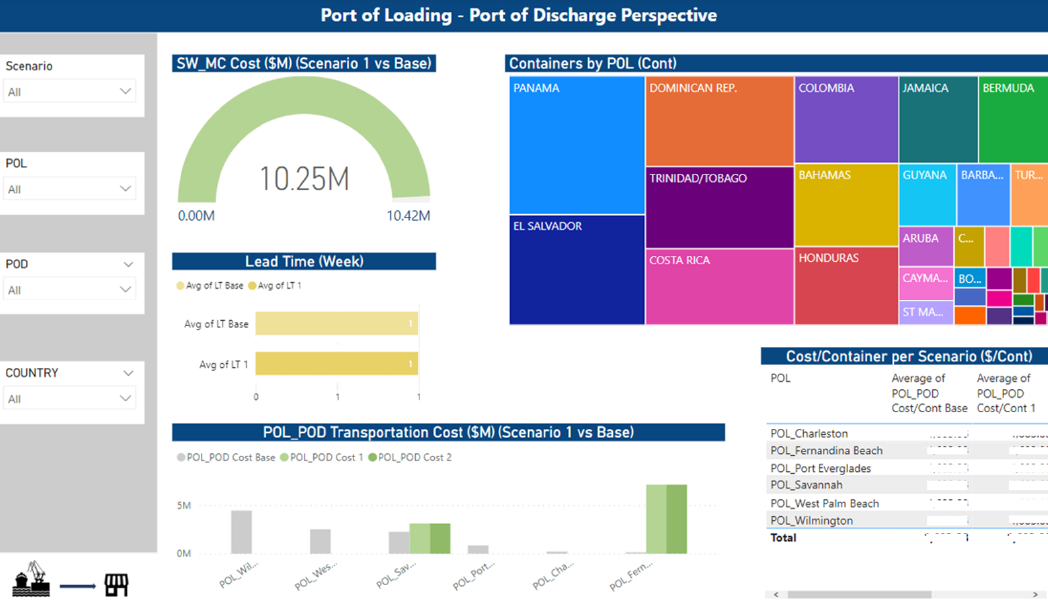
Figure A4. Summary of Port of Loading to Port of Discharge Perspective. The legend corresponds to the notation introduced in Section 4.3.1.